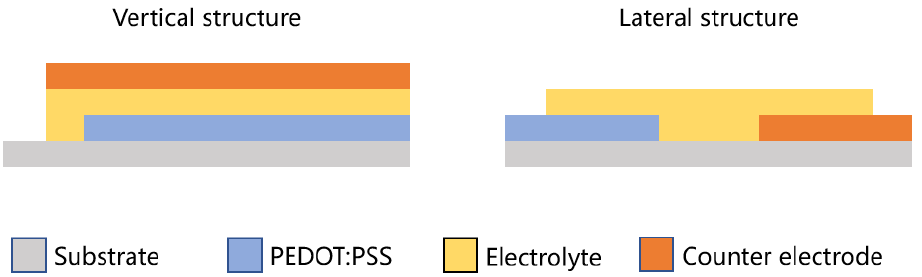
Figure 4. Schematic representation of the vertical and lateral structure of ECDs, using PEDOT:PSS as the EC material that can also serve as electrode. The counter electrode can also use PEDOT:PSS or other materials. Opaque materials such as PET are usually chosen for the substrate to improve the electrochromic contrast [63].